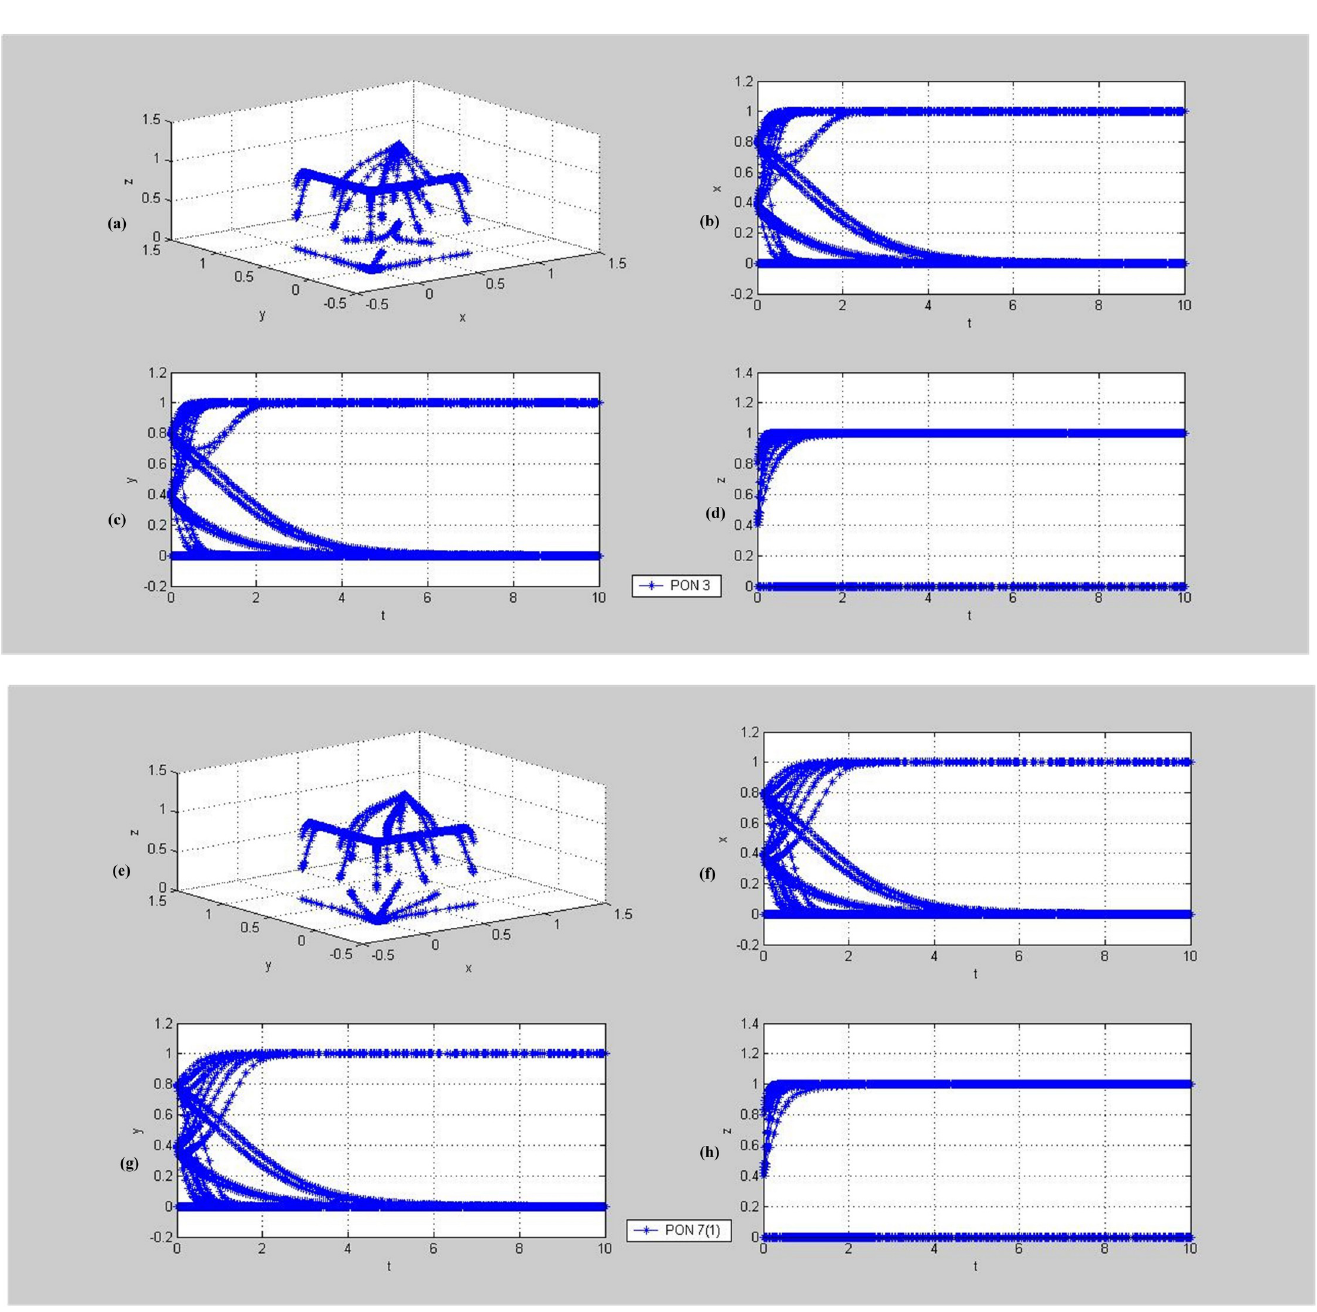
Fig 8. Evolutionary dynamics of mixed strategies (cooperation, cooperation, supervision) or (betrayal, betrayal, supervision). PON-Proposition. (a)~(d) demonstrate the phase trajectories of x, y, z and (x, y, z) in the game situations shown in Proposition 3: (a) The phase trajectory of (x, y, z) of the entire evolutionary game system over time t; (b) the dynamic evolution characteristic of x, i.e., the proportion of individuals choosing Cooperation strategy in population PPP over time t; (c) the dynamic evolution characteristic of y, i.e., the proportion of individuals choosing Cooperation strategy in population DC over time t; (d) the dynamic evolution characteristic of z, i.e., the proportion of individuals choosing Supervision strategy in population TPIP over time t. (e)~(h) demonstrate the phase trajectories of x, y, z and (x, y, z) in the game situations shown in Proposition 7(1): (e) The phase trajectory of (x, y, z) of the entire evolutionary game system over time t; (f) the dynamic evolution characteristic of x, i.e., the proportion of individuals choosing Cooperation strategy in population PPP over time t; (g) the dynamic evolution characteristic of y, i.e., the proportion of individuals choosing Cooperation strategy in population DC over time t; (h) the dynamic evolution characteristic of z, i.e., the proportion of individuals choosing Supervision strategy in population TPIP over time